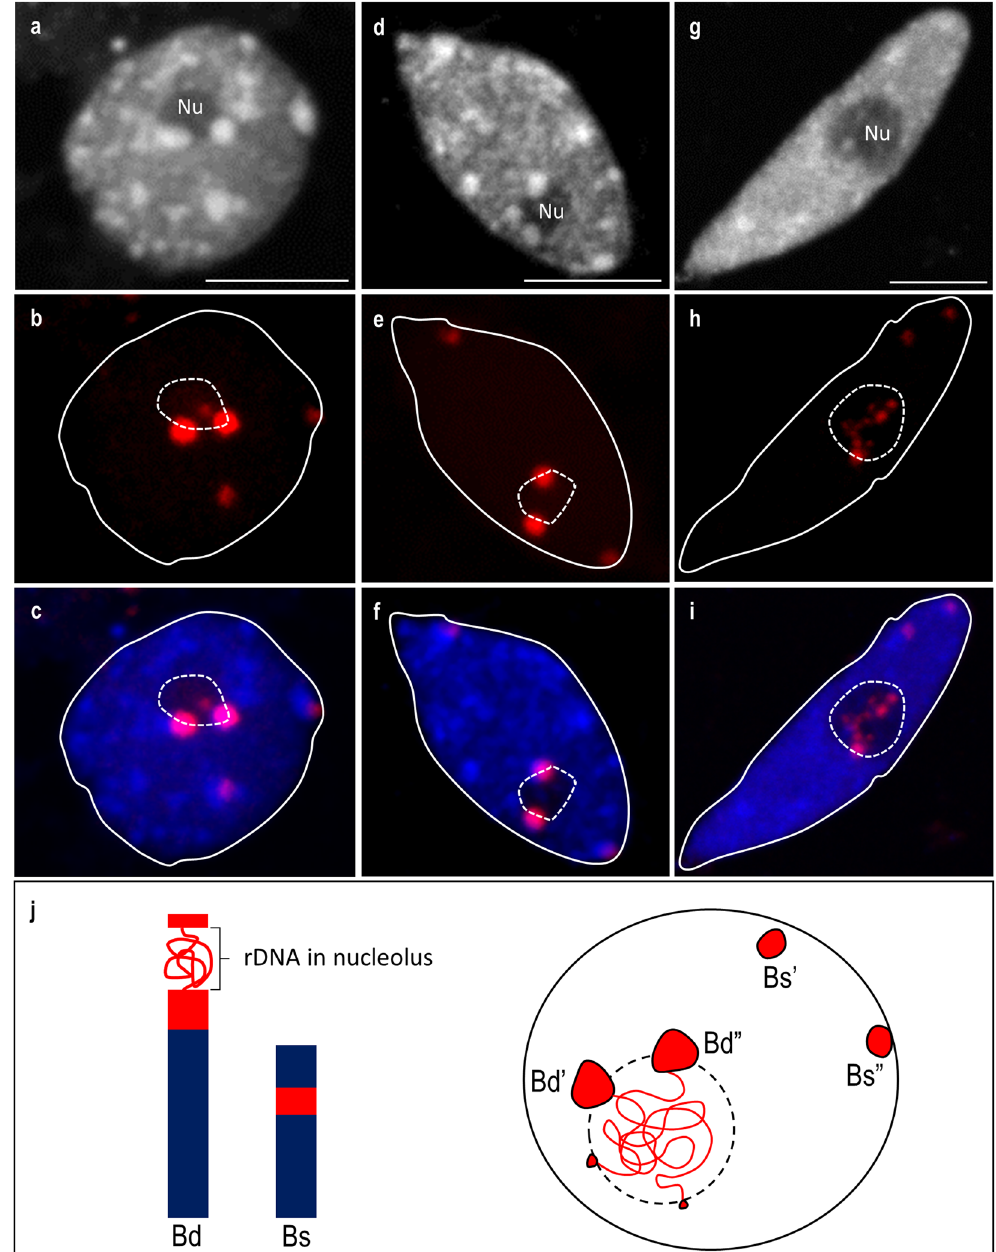
Figure 3. Distribution of 25S rDNA FISH signals in B. hybridum root nuclei of different shapes: spherical (a–c) , elongated (d–f) and rod-shaped (g–i) . (a , d , g) DAPI counterstained nuclei. (b , e , h) 25S rDNA hybridisation signals (red fluorescence). (c , f , i) Superimposed images of 25S rDNA FISH signals and counterstained chromatin. (j) The model of the 35S rRNA genes distribution in metaphase chromosomes (left) and interphase nucleus (right) of B. hybridum . Nu–nucleolus. Scale bar: 5 µ